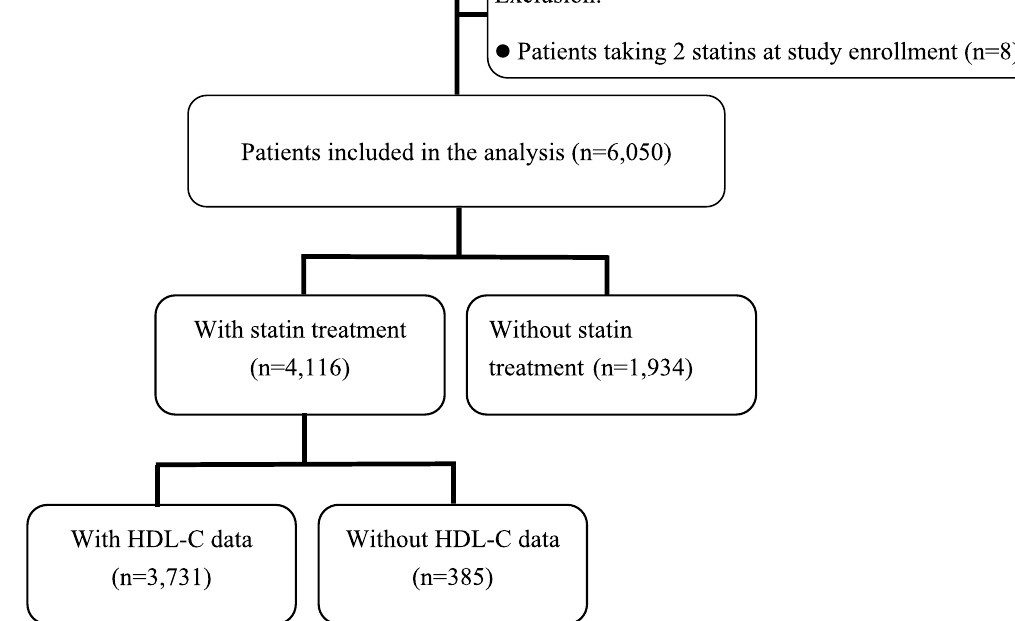
Figure 1. Flow chart for the inclusion and exclusion of study patients. ASCVD, atherosclerotic cardiovascular disease; HDL-C, high-density lipoprotein cholesterol; NCEP, National Cholesterol Education